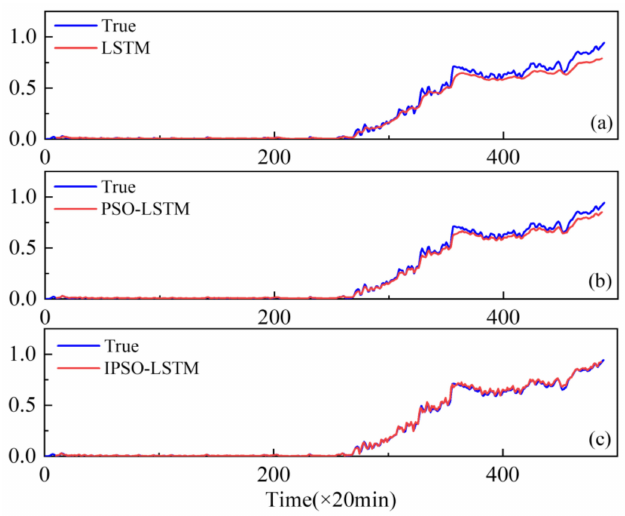
Figure 6. Performance degradation predictions for outer bearings for the: ( a ) LSTM; ( b ) PSO-LSTM; ( c ) IPSO-LSTM.